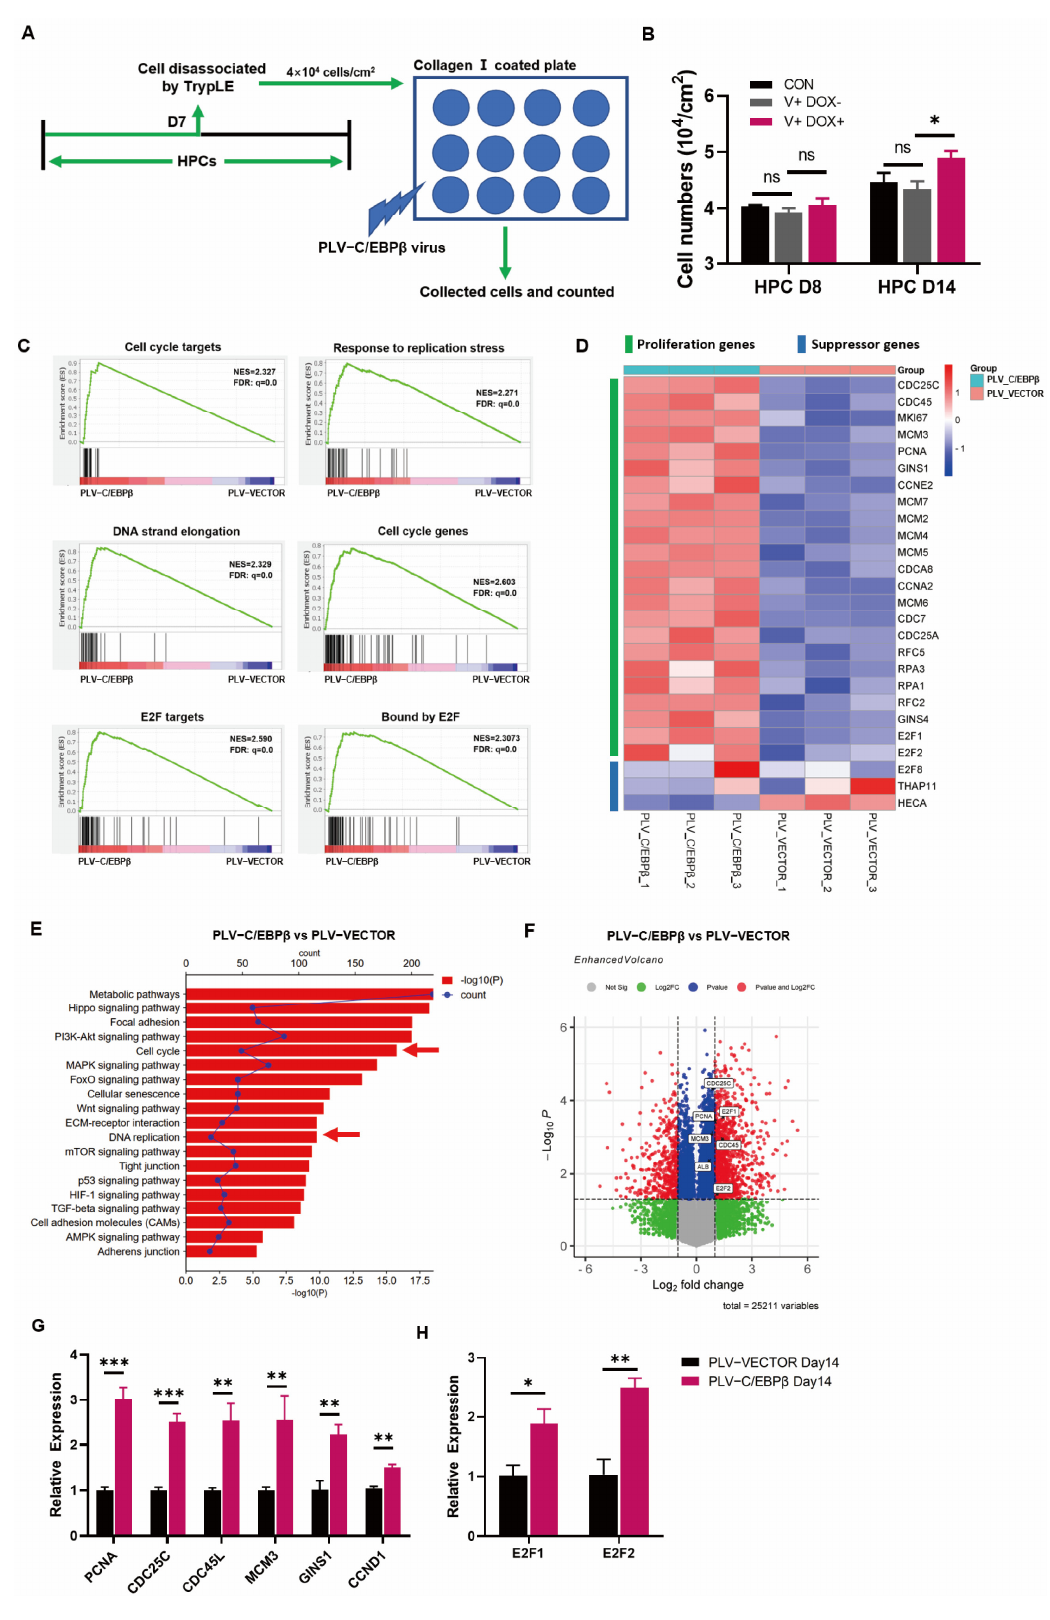
Figure 3. The overexpression of C/EBP β promoted the proliferation of HPCs. ( A ) The diagram shows that cells were disassociated by TrypLE at HPC D7 and then seeded at 4 × 10 4 cells/cm 2 on